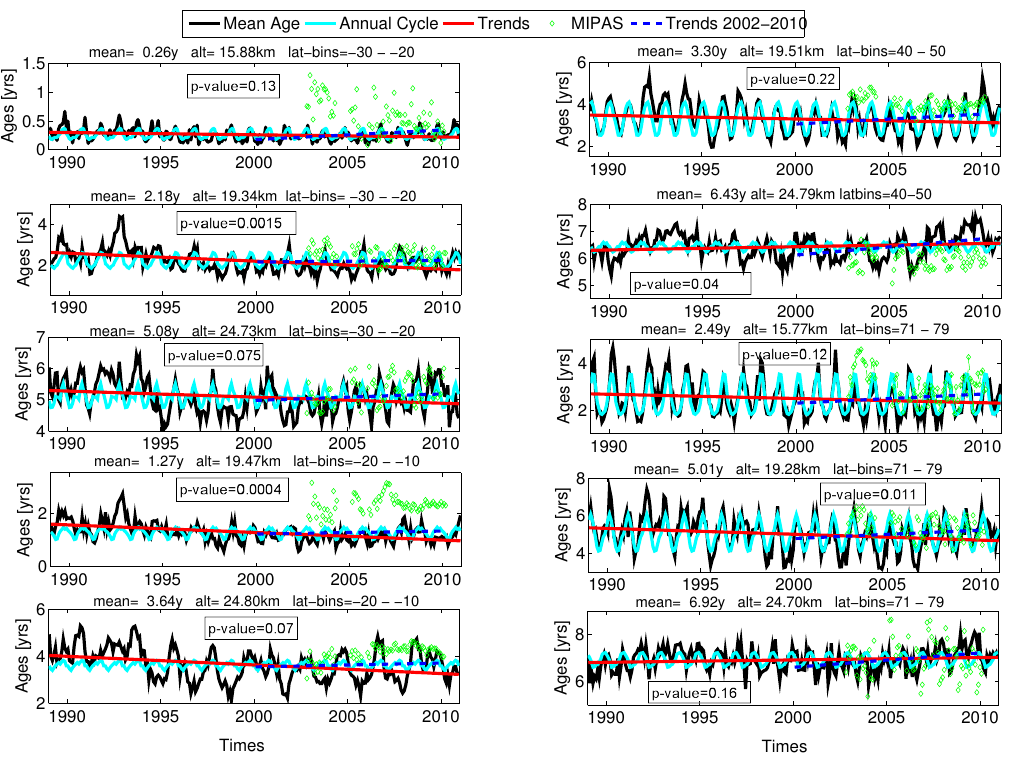
Fig. 15. Evolution of mean age compared with SF 6 ages at several heights and latitudes. (Three first rows of left column): southern subtropics (30 ◦ S to 20 ◦ S) at 16.5, 20 and 25.5km. (Last two rows of left column): inner tropics (20 ◦ S to 10 ◦ S) at 20 and 25.5km. (Two first rows of right column): northern mid-latitudes (40 ◦ N to 50 ◦ N) at 17 and 20km. (Three last rows of right column): northern polar region (71 ◦ S to 79 ◦ N) at 16.5, 20 and 25.5km. (Black): mean age. (Cyan): annual cycle of the mean age. (Red): trend of the mean age derived from the least squares method. (Green diamond): SF 6 MIPAS data. (Dash blue): trend of the mean age derived from the least squares method over 2000–2010. The p -value of the trend is shown in a box for each panel.